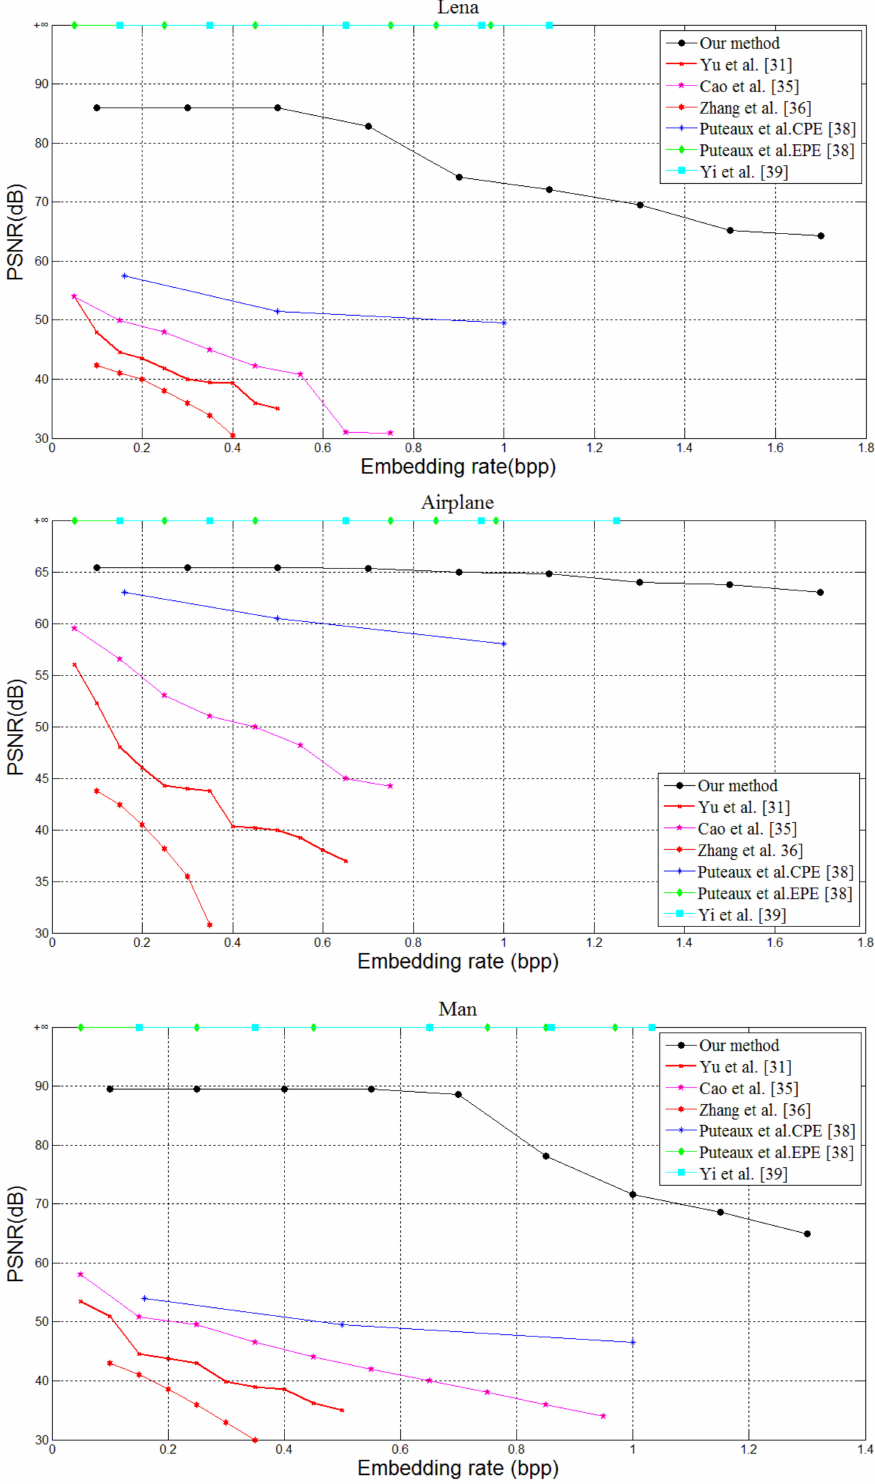
Figure 10. Performance comparisons for the tested images Lena, Airplane, and Man with the methods